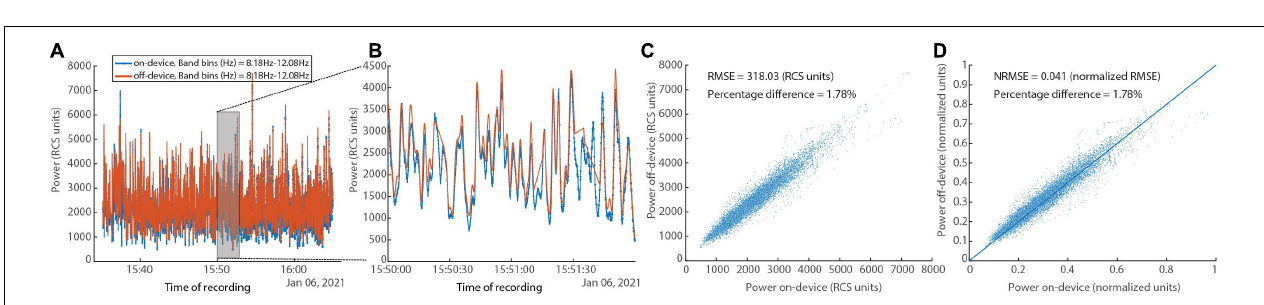
FIGURE 10 | In vivo human data set showing on-device and off-device calculated power series for a given frequency band (8.05–12.20 Hz). (A) Overlay of power time series for the “on-device” and the “off-device” calculation. (B) Zoom into a 2-min segment showing minimal difference between the two power series. (C) Scatter plot showing the fit between the “on-device” and “off-device” power values with RMSE of 318.03 (RCS units) and percentage difference of 1.78%. (D) Scatter plot showing the fit between the “on-device” and “off-device” power values with normalized RMSE of 0.041 and percentage difference of 1.78%.